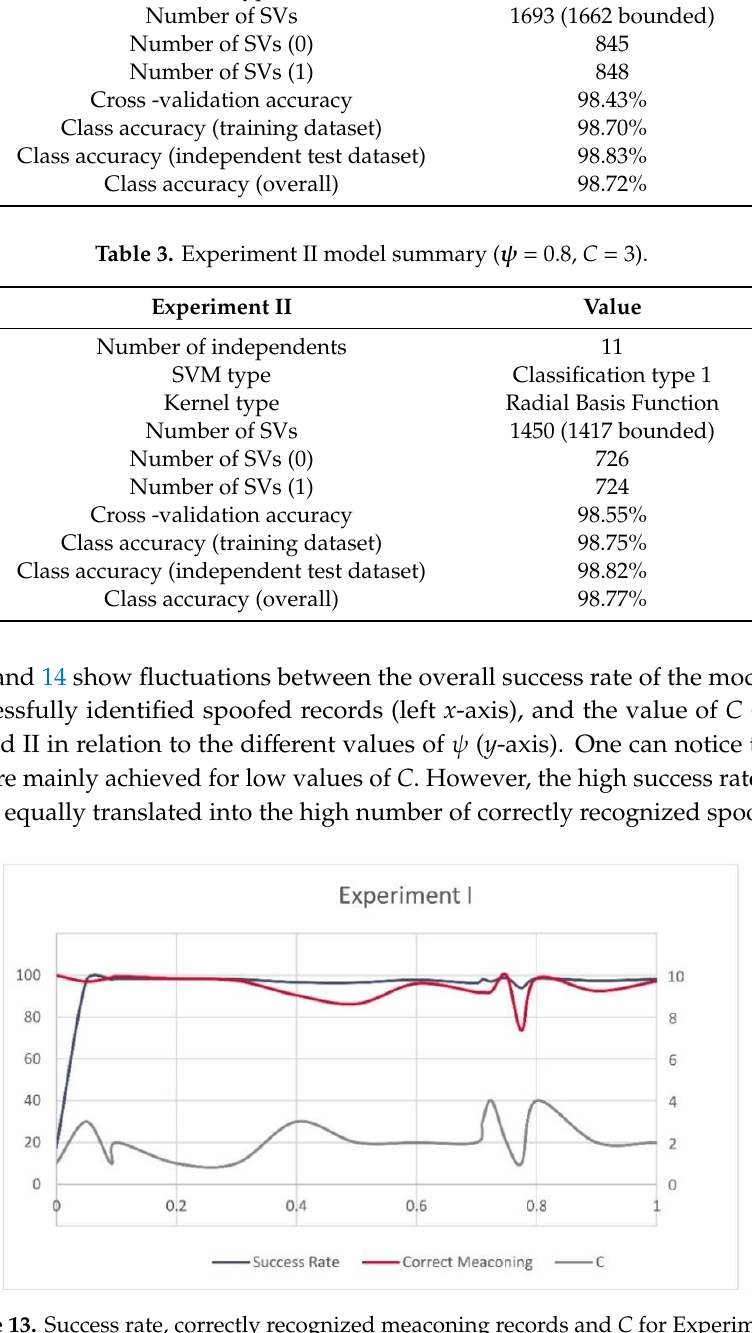
Table 3. Experiment II model summary ( 𝝍 = 0.8, C = 3).